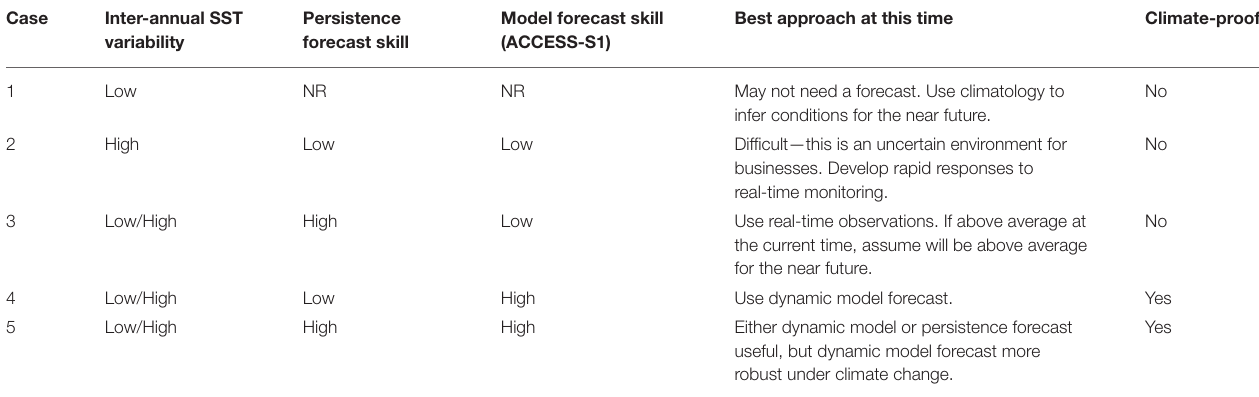
TABLE 1 | Managing environmental variability at the present location is possible with several different approaches, depending on the historical environmental variability (in this case SST), the skill of a persistence forecast, and the skill of the dynamic model forecast. Case Inter-annual SST Persistence Model forecast skill Best approach at this time variability forecast skill (ACCESS-S1)